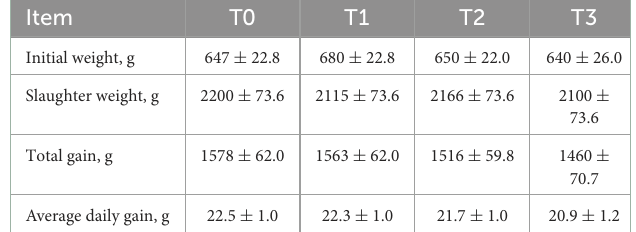
TABLE 1 Percentage composition determining the nutrient content of the different experimental diets.